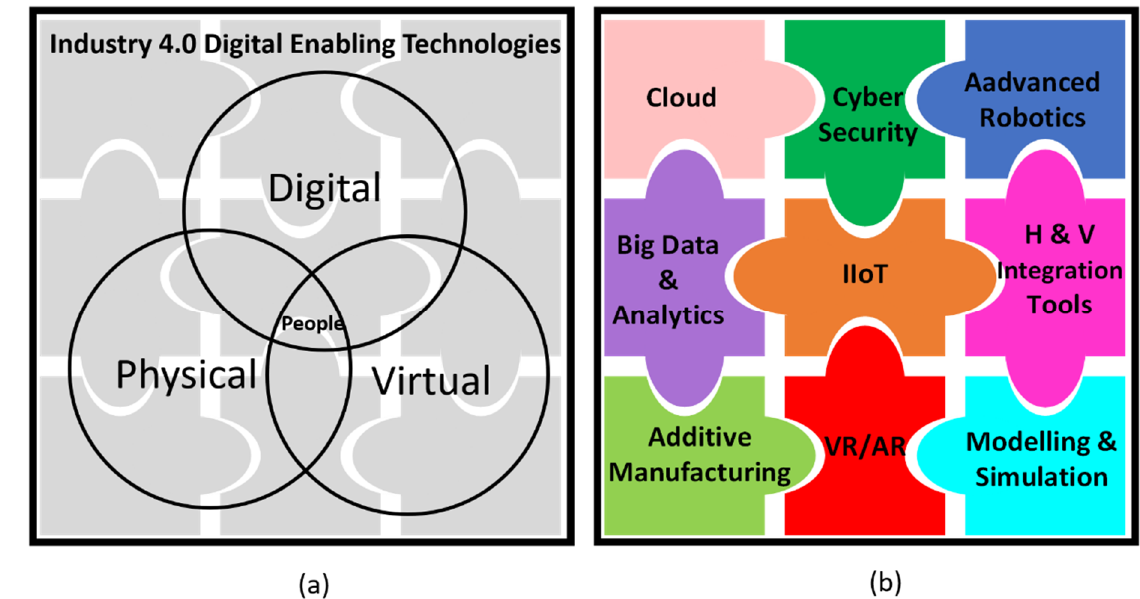
Figure 3. Connectivity relationship circles and Industry 4.0 digital technology Jigsaw map. ( a ) Connectivity relationship circles of the three entities (digital, physical and virtual); ( b ) technology jigsaw map. (IIoT: Industrial Internet of Things, AI: artificial intelligence, VR: virtual reality, AR: argumentative reality, H&V Integration tools: horizontal and vertical integration tools, 5G: fifth generation communication technology). (Author’s creation).